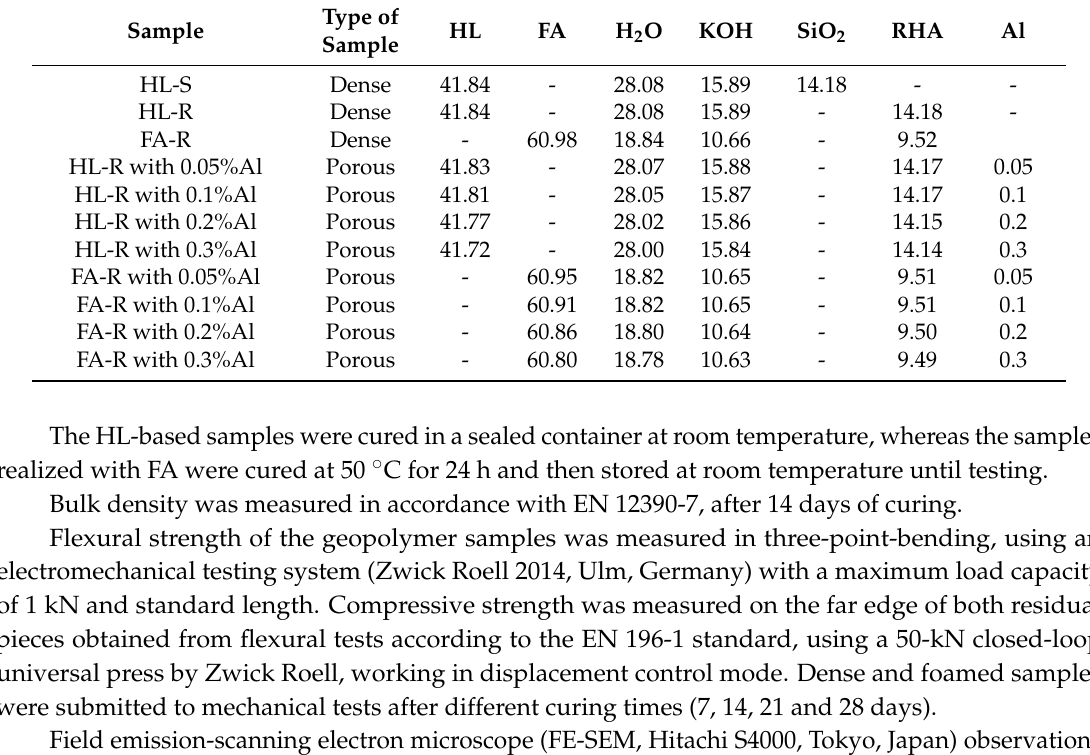
Table 2. Designation and chemical composition (expressed as wt %) of the geopolymer pastes (HL-S, HL-R, FA-R) and of the macroporous samples.